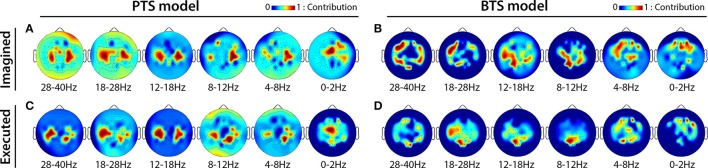
Cross-subject based topographical maps. Topographical distribution of electrode contribution to the reconstruction of arm movement trajectory. Color coding—averaged contribution of significant channels [p < 0.05, Student two-tailed t-test corrected for FDR (false discovery rate)] based on accuracy rates of single channel setups over 12 subjects indicating cortical areas providing a high contribution for trajectory decoding. (A,C) present topographical maps for imagined and executed arm movements using band-pass filtered potentials for the PTS model, respectively. (B,D) Present topographical maps for imagined and executed arm movements using PSD values for the BTS model, respectively.